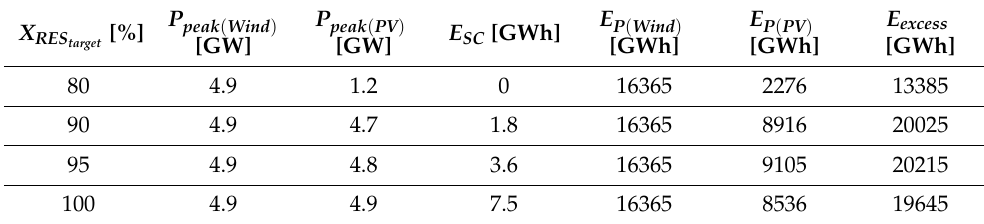
Table 6. Minimum storage capacity requirement (𝐸 (cid:3020)(cid:3004) ) and the installed power for wind ( 𝑃 (cid:3043)(cid:3032)(cid:3028)(cid:3038)((cid:3024)(cid:3036)(cid:3041)(cid:3031)) ) and PV (𝑃 (cid:3043)(cid:3032)(cid:3028)(cid:3038)((cid:3017)(cid:3023)) ) systems and the generated energy 𝐸 (cid:3017)((cid:3024)(cid:3036)(cid:3041)(cid:3031)) and 𝐸 (cid:3017)((cid:3017)(cid:3023)) for wind and PV, respectively, and the excess energy (𝐸 (cid:3032)(cid:3051)(cid:3030)(cid:3032)(cid:3046)(cid:3046) ) that is not consumed by the plant, for each target renewable energy share ( 𝑋 (cid:3019)(cid:3006)(cid:3020) ).